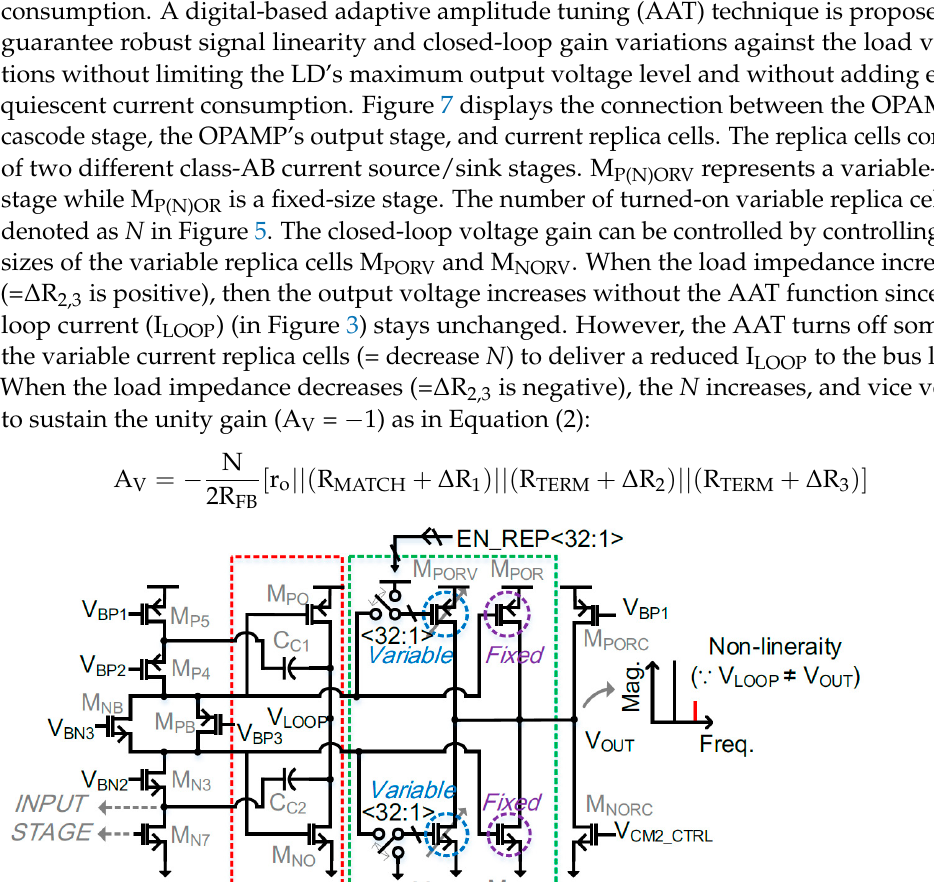
comparably negligible in Equation (2). The unity-gain property not only mitigates the close-loop gain variations, but also alleviates signal linearity variations since the proposed AAT keeps the output voltages V LOOP and V OUT the same. In addition, the current replica cells prevent the OPAMP’s stability, bandwidth and loop-gain variations against the R L variations since the current replica cells act as buffers between the OPAMP and the bus lines. The 32-bit thermometer digital code EN_REP controls the number of turned-on variable replica cells. In this design, the number of gate fingers for M P(N)O , M P(N)ORV ,